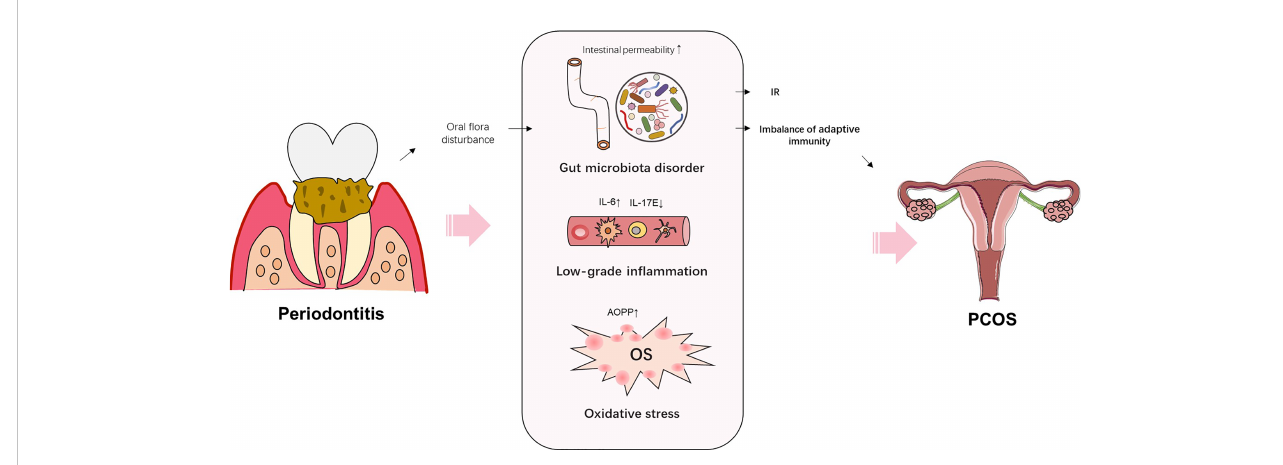
FIGURE 2 Schematic representation of the potential mechanisms by which periodontitis increases the risk of